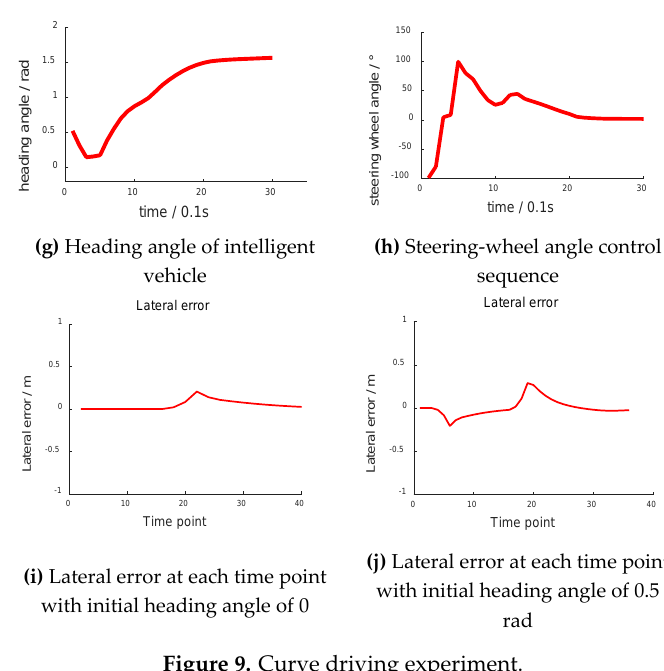
Figure 9. Curve driving experiment.